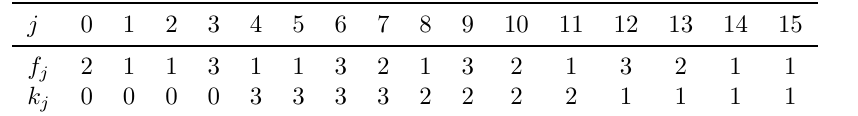
Table 1: MixColumns constants f j and k j to use in step 3 of the attack (Eqn (3))